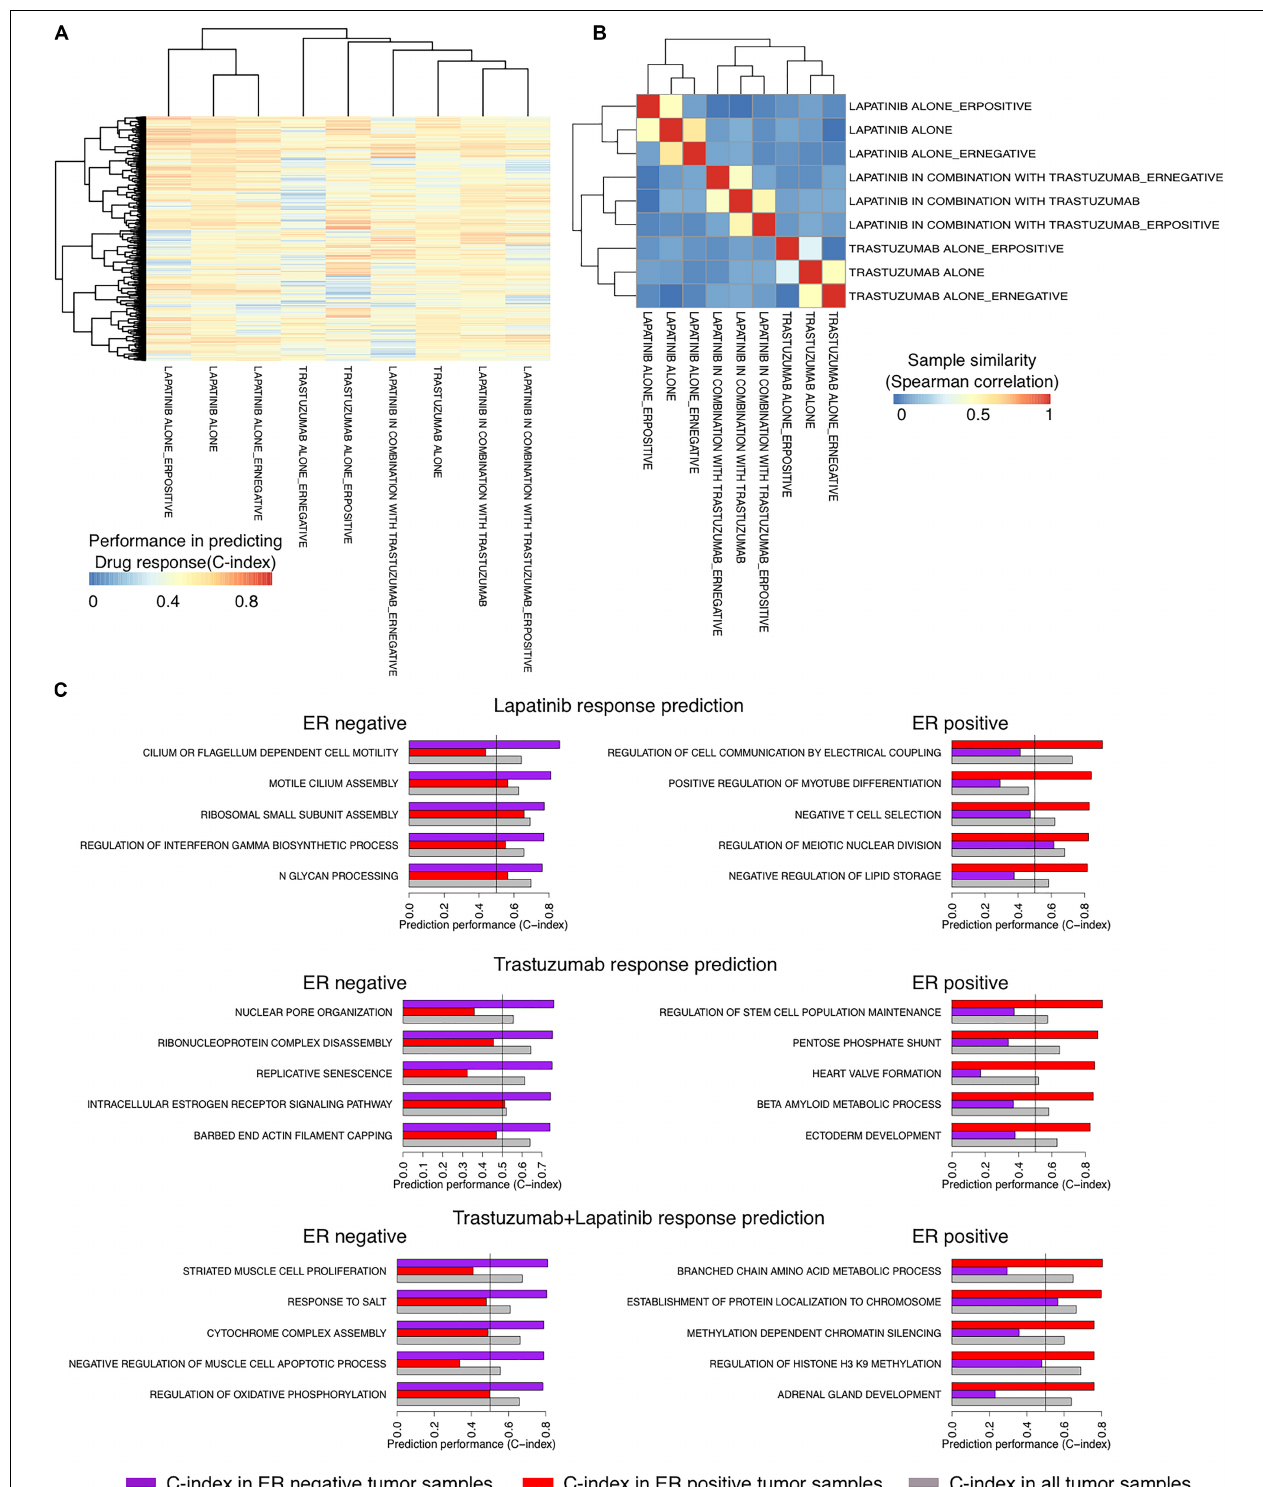
FIGURE 3 | Identifying responders to lapatinib, trastuzumab, and their combination therapy in the NeoALTTO clinical trial using the transcriptional similarity coefficient (TSC) of pathways. (A) Concordance indices of delta TSCs of GO terms, comparing each sample with responders and non-responders, in predicting the response of patients to lapatinib, trastuzumab, and their combination. (B) Clustering of groups of patients based on Concordance indices of delta TSC of GO terms (A) . (C) Top pathways as predictors of lapatinib, trastuzumab, and their combination in ER+ and ER– tumor samples in the NeoALTTO clinical trial.